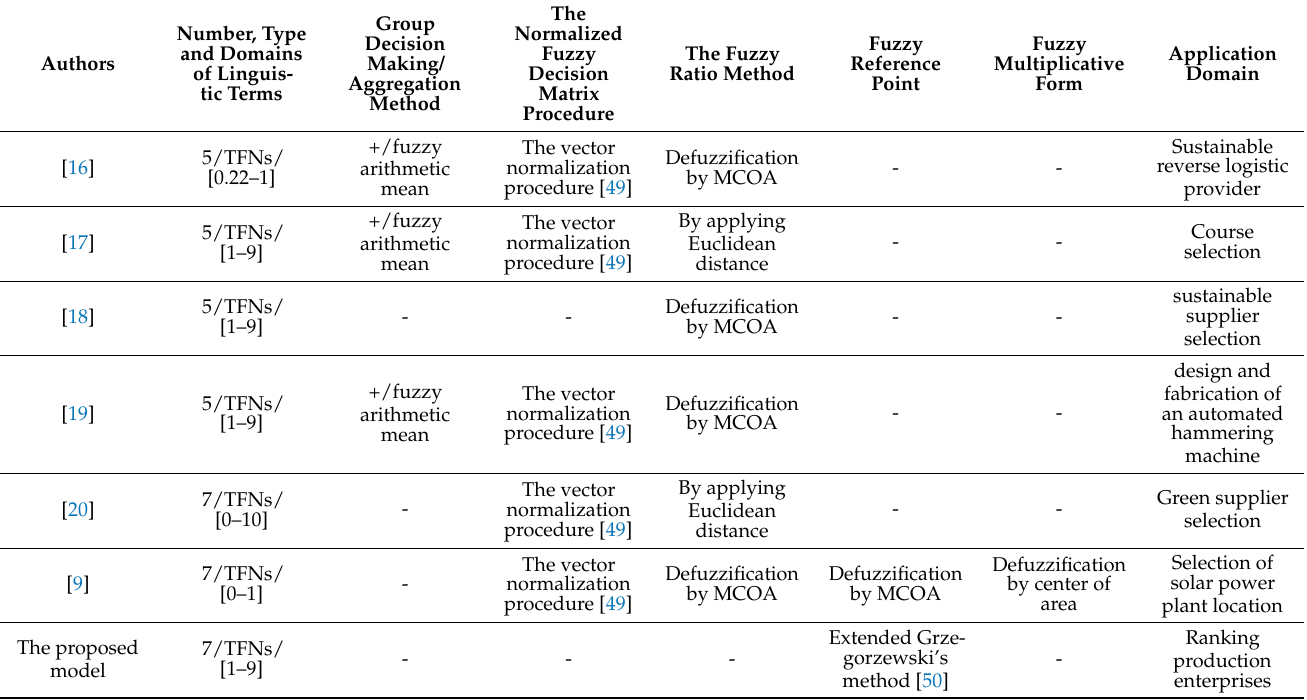
Table 3. Comparative analyses the proposed